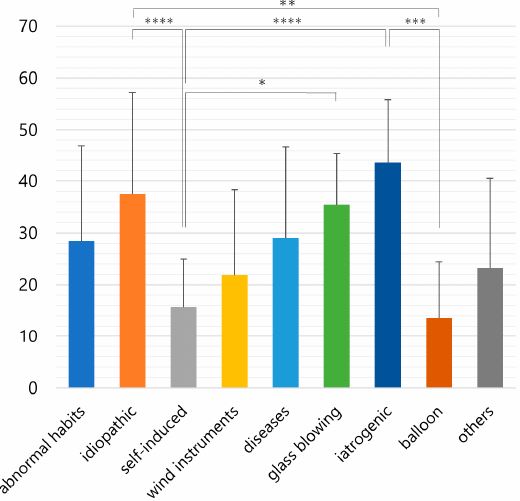
Figure 5. Mean age for each etiology. * p < 0.05, ** p < 0.01, ** * p < 0.005, *** * p < 0.001.